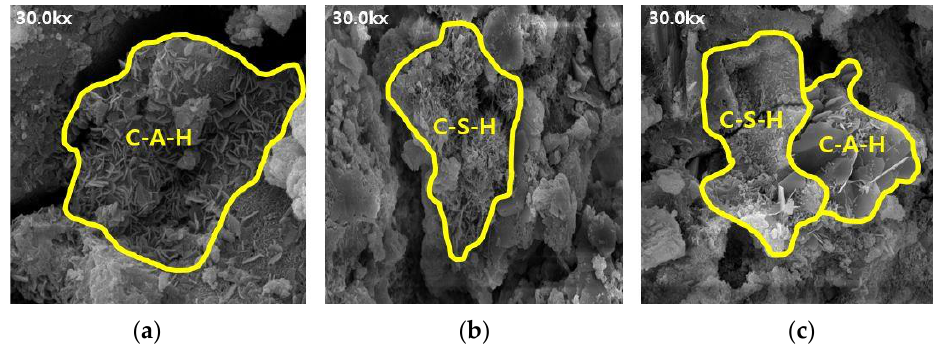
Figure 8. SEM results of ABFS50: ( a ) 3, ( b ) 7, and ( c ) 28 d.